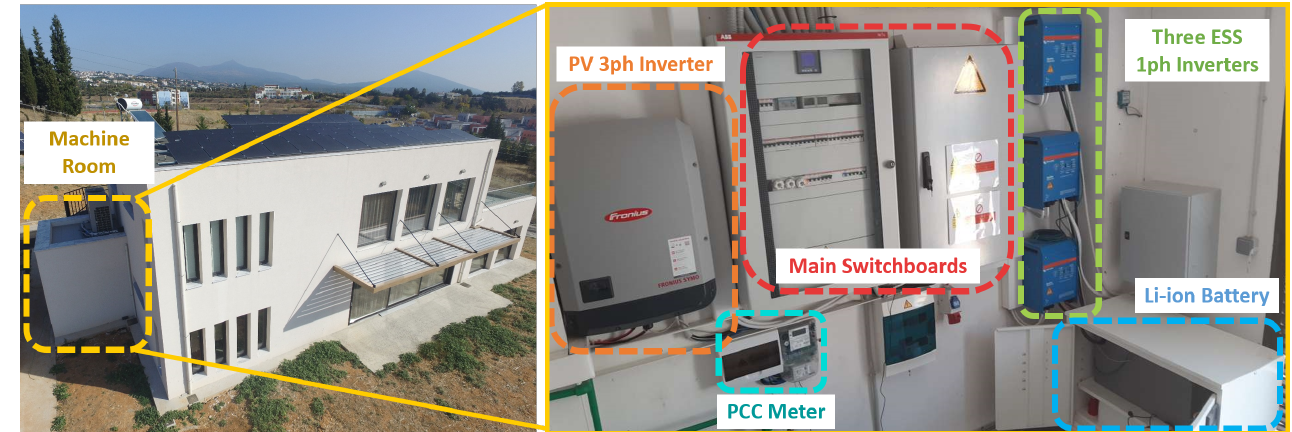
Figure 3. SmartHome microgrid